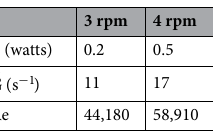
− G and Reynolds numbers for the two rotating Table 1. Power,